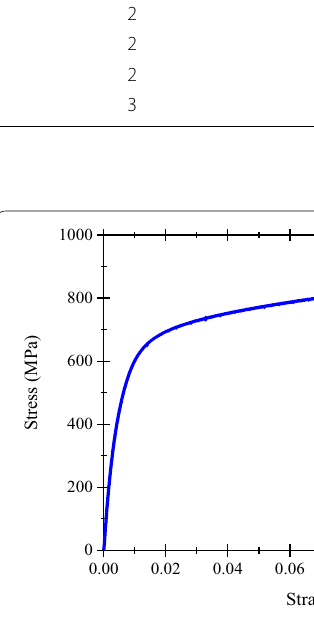
Fig. 2 Stress–strain curves from direct tension test for